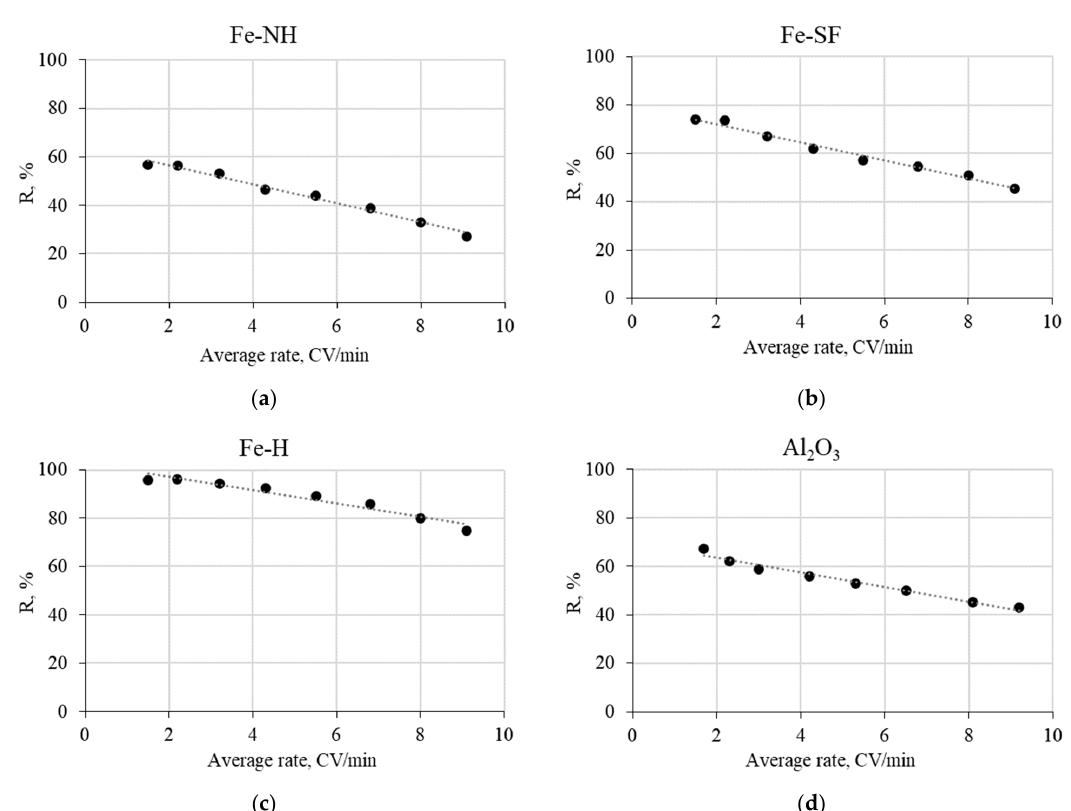
Figure 2. Dependence of 32 P, 33 P recovery efficiency ( R , %) on the seawater flow rate by the sorbents: ( a ) Fe-NH; ( b ) Fe-SF; ( c ) Fe-H, ( d ) Al 2 O 3 (single-column method, the volume of the sorbent 50 mL, volume of seawater—250 L).